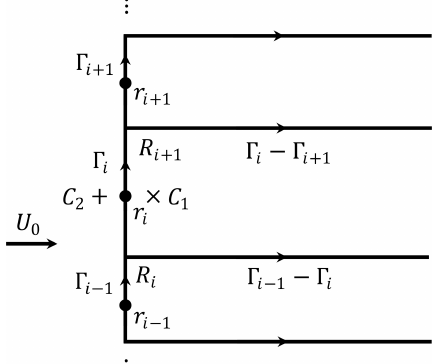
Figure 4. Side view of the vortex system of the non-planar rotor and the corresponding planar rotor. The two vortex systems have the same radial discretization and radial distribution of bound vorticity. The tangential and longitudinal trailed vorticity strengths of the two systems will be identical.